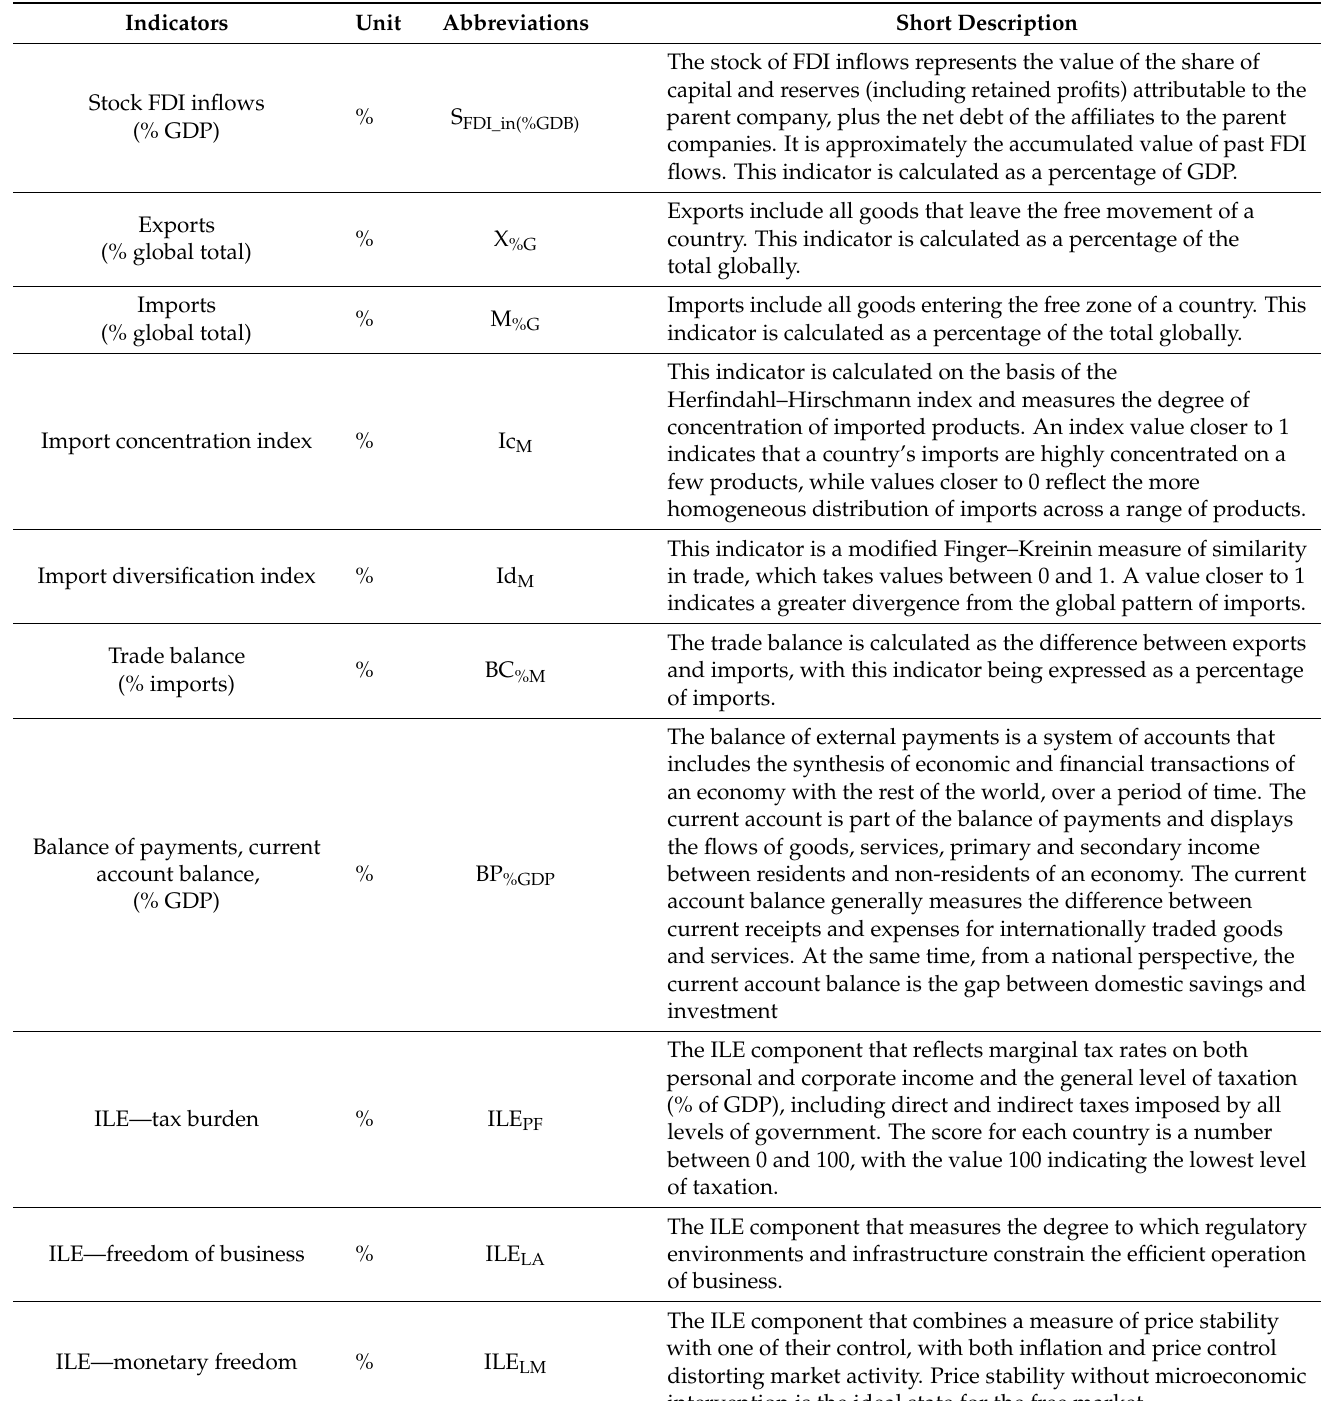
Table 1. Economic indicators used in the economic modeling of stock FDI